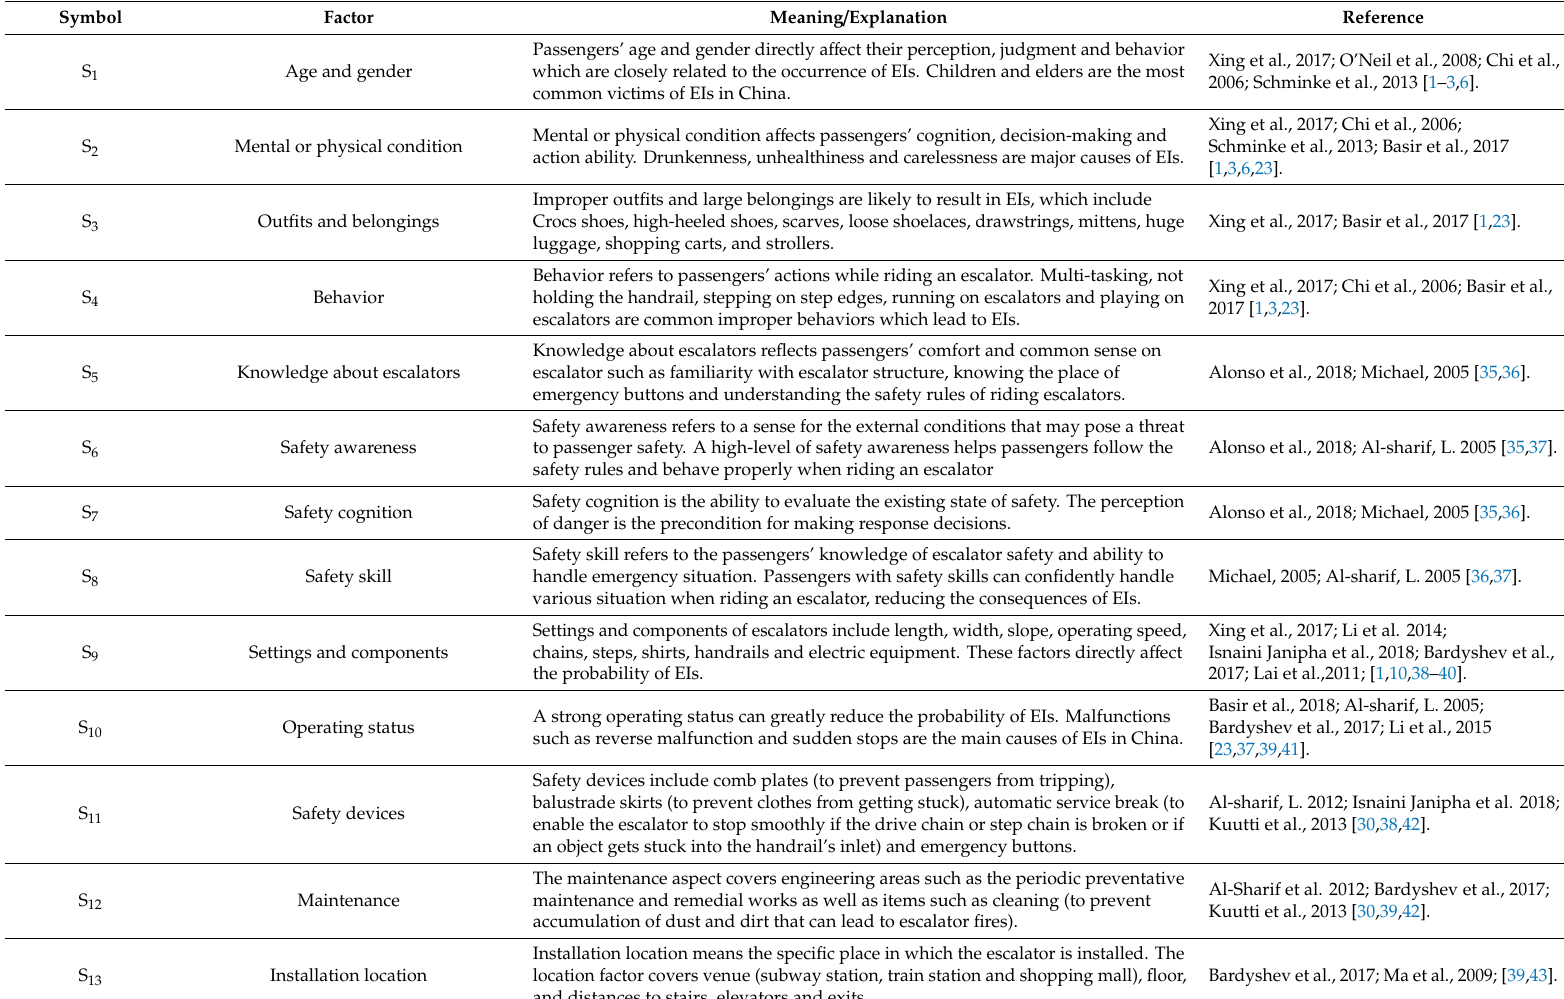
Table 3. Influencing factors of